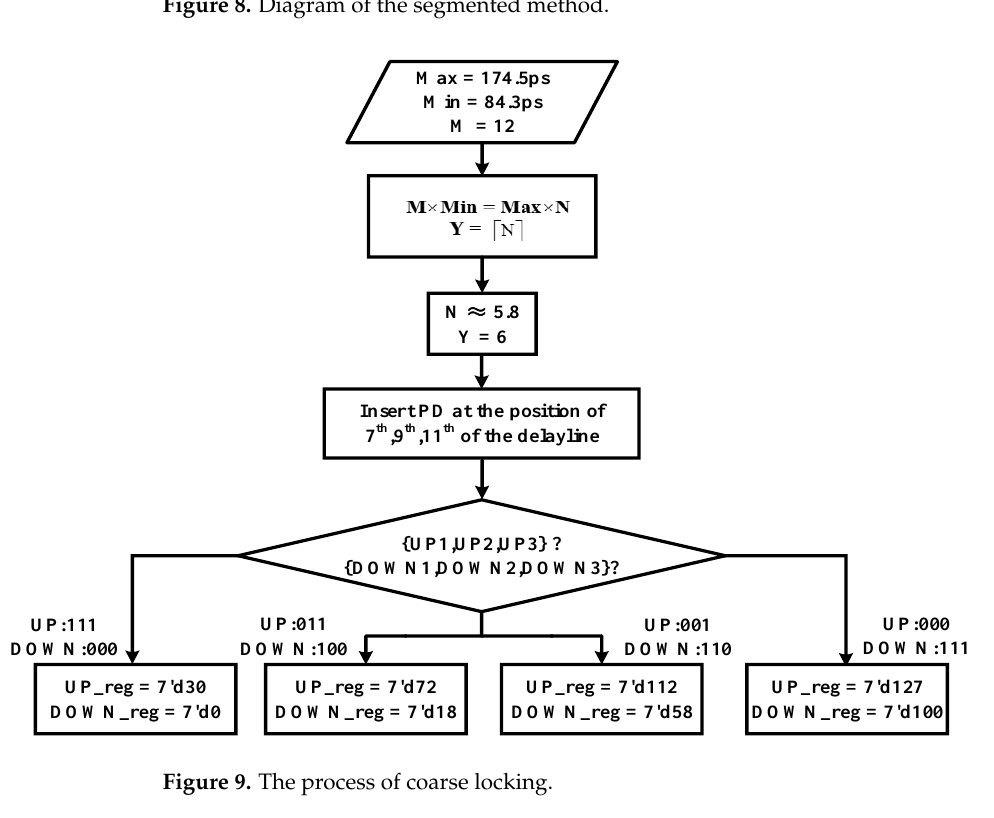
Figure 9. The process of coarse locking.